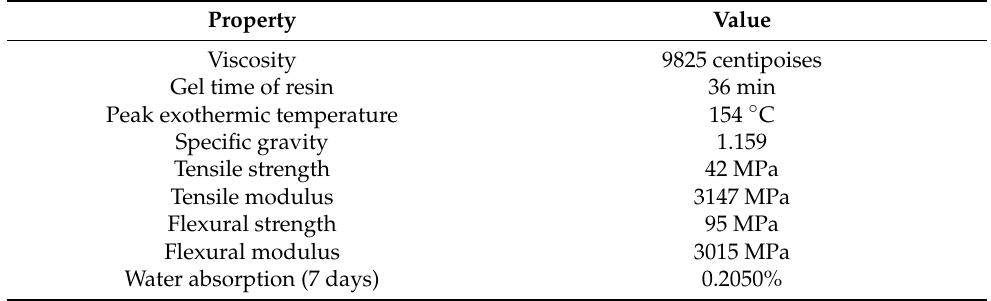
Table 1. Properties of resin.